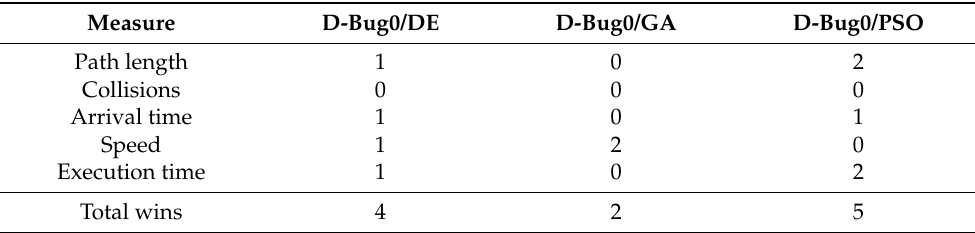
Table 4. Summary of the pairwise Wilcoxon tests over the results of the 30 independent executions with D-Bug0/DE, D-Bug0/GA, and